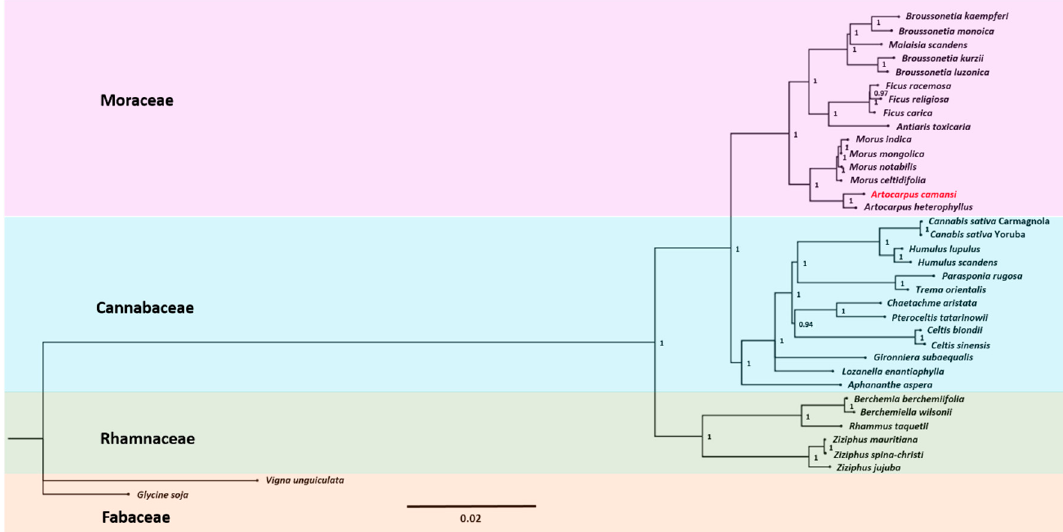
Figure 8. Phylogeny of 33 species of the families Moraceae, Rhamnaceae, and Cannabaceae, based on the sequences of 56 chloroplast genes. Numbers represent the Bayesian posterior probability given to each node. Glycine soja and Vignia unguiculata are the